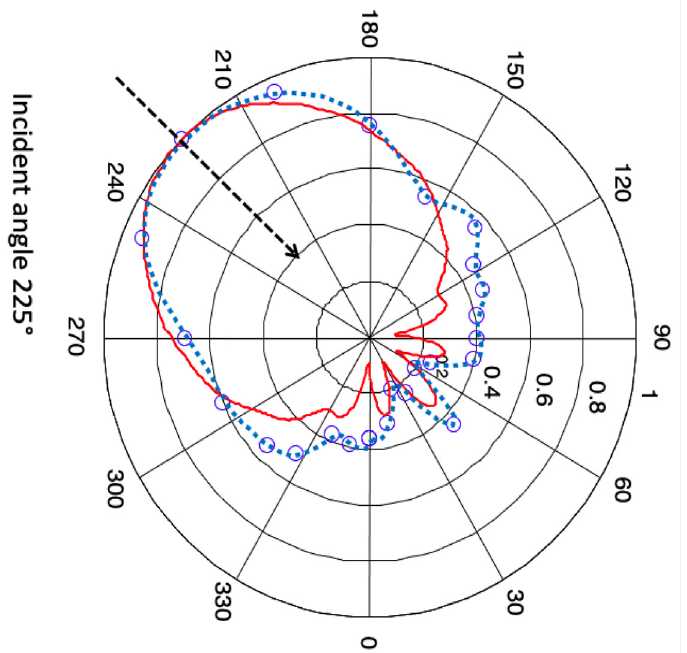
Figure 11. Experimental measurements (dashed) and numerical predictions (solid) of the total displacement field of A 0 mode propagating in the impacted CFRC plate.